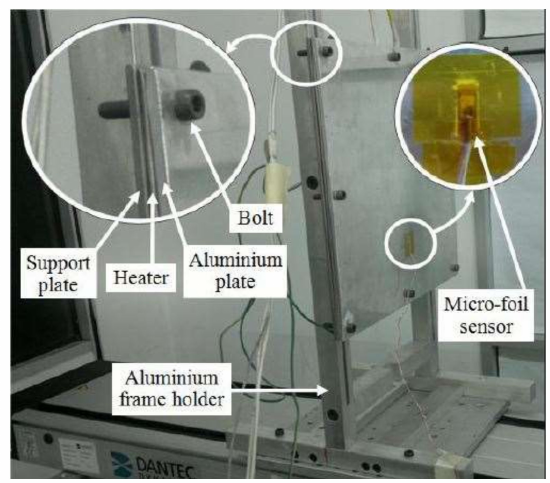
Figure 1. Impingement